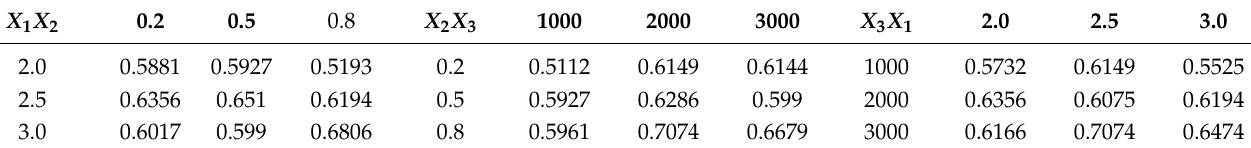
Table 11. Interaction effects of the selected parameters on mean GRG values.